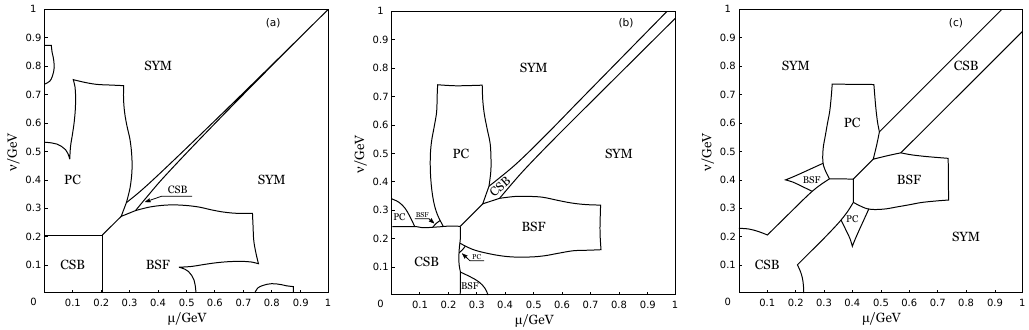
Figure 3 . (a) ( (cid:22); (cid:23) )-phase diagram at (cid:23) 5 = 0 : 2 GeV. (b) ( (cid:22); (cid:23) )-phase diagram at (cid:23) 5 = 0 : 24 GeV. (c) ( (cid:22); (cid:23) )-phase diagram at (cid:23) 5 = 0 : 4 GeV. All the notations are the same as in (cid:12)gure 1. region (cid:23) < (cid:22) (cid:25) (cid:23) ), what is not in agreement with the phase diagrams of (cid:12)gures 5